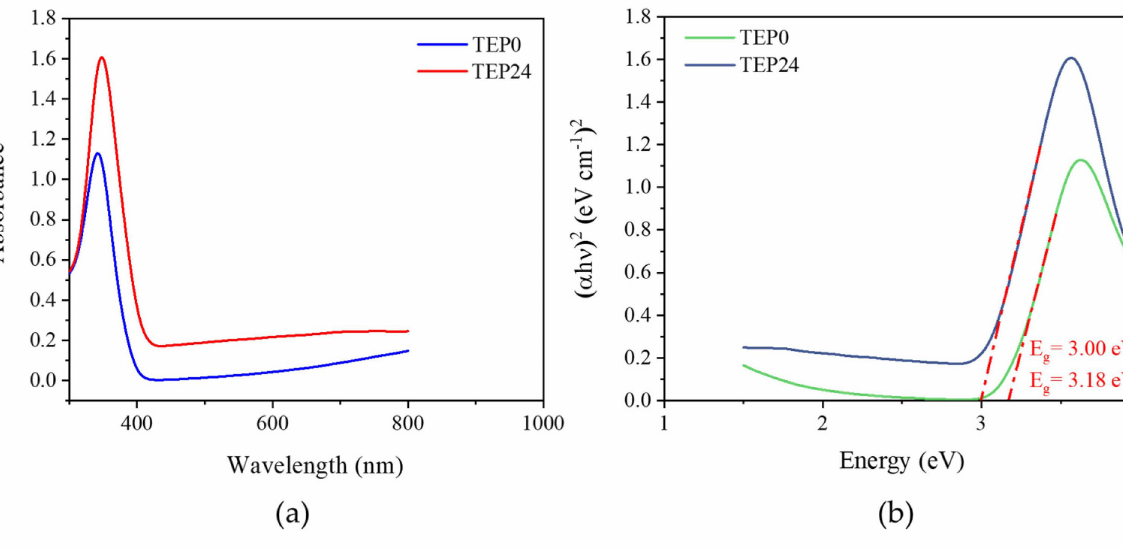
Figure 6. ( a ) UV–Vis DRS and ( b ) corresponding Kubelka–Munk function plots of different